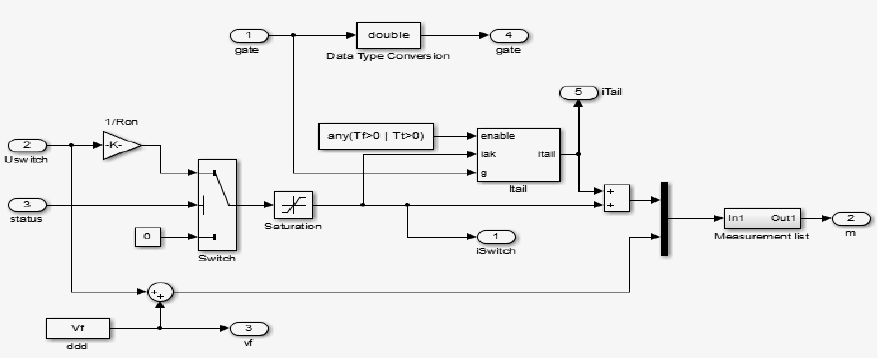
Figure 8. Simulink model of DC-to-DC chopper.